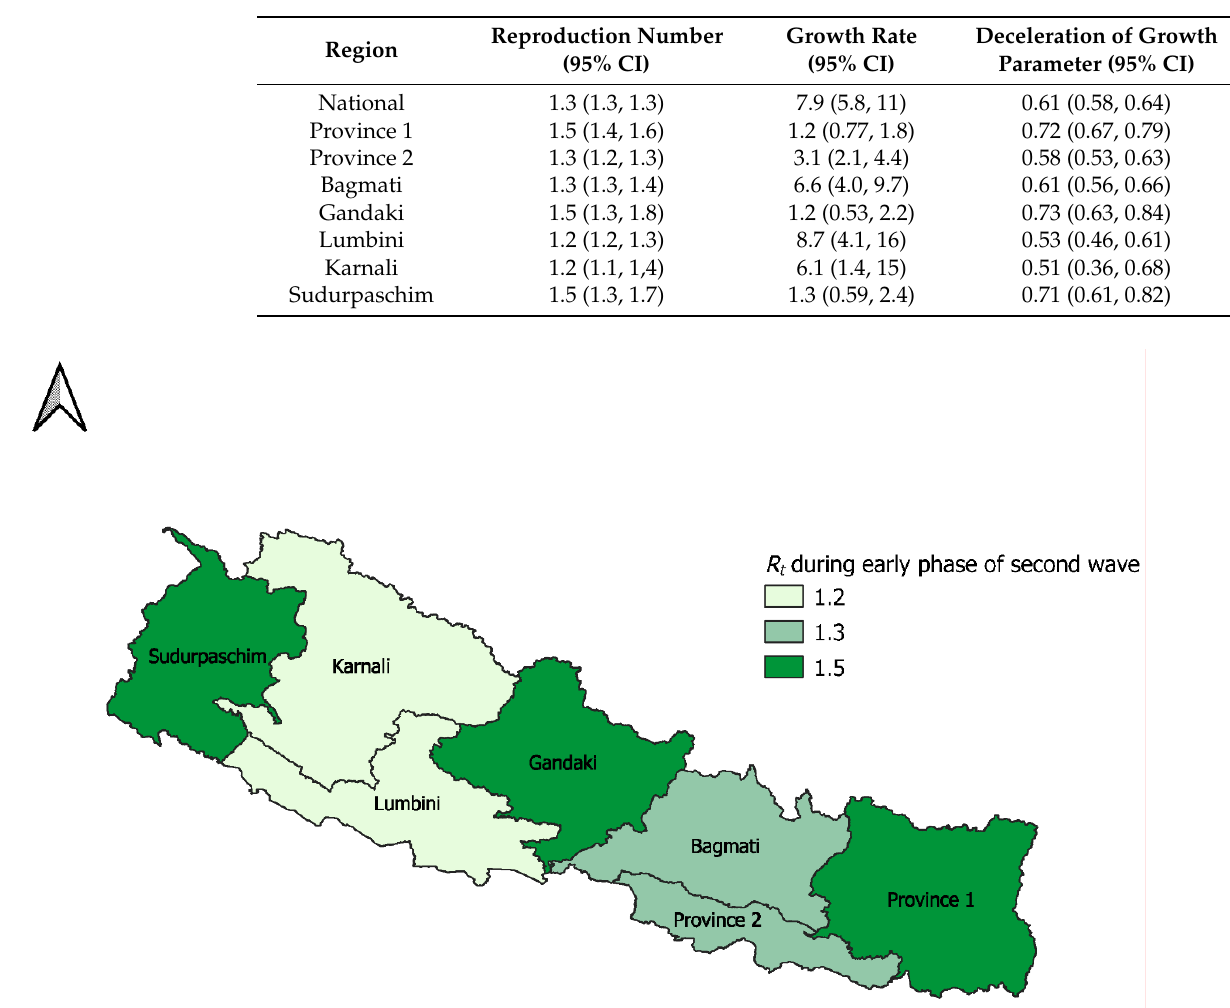
Table 4. Comparison of reproduction number estimated using GGM for provinces, for first 30 days of second wave (12 April–11 May 2021).